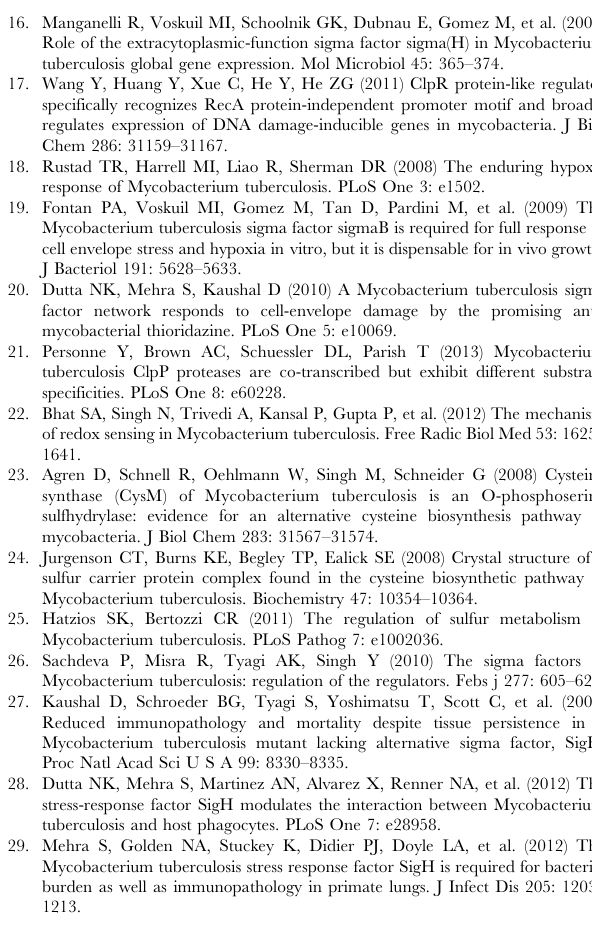
Figure S1 PCR Screening for Mtb : D Rv2745c. a. PCR using Rv2745c primers. Amplification of , 339 base pairs in lane 4 shows the presence of Rv2745c in Mtb wild type, while its absence in lane 5 indicates deletion of Rv2745c from Mtb : D Rv2745c. b. PCR amplification of hyg r . The absence of a band in lane 4 confirms the expected finding that hyg r is not present within the Mtb genome. The presence of a band from hyg r carrying plasmid as well as from genomic DNA derived from Mtb : D Rv2745c is indicative of the replacement of Rv2745c by hyg r (Lane 5). Lane